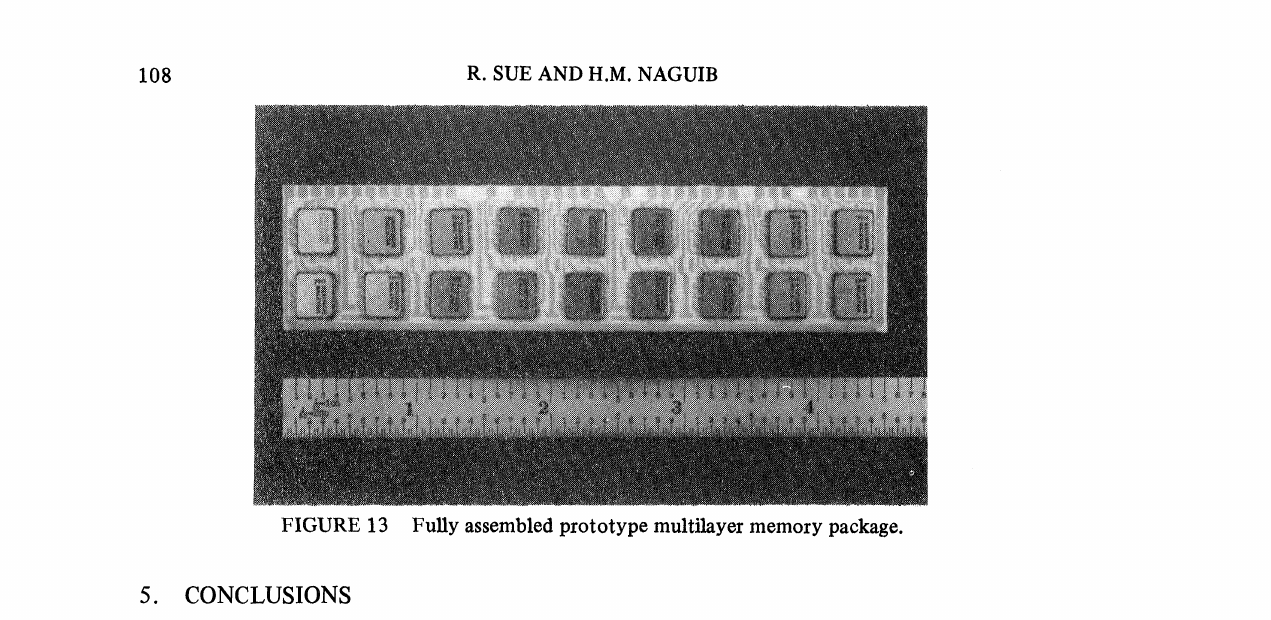
FIGURE 13 Fully assembled prototype multilayer memory